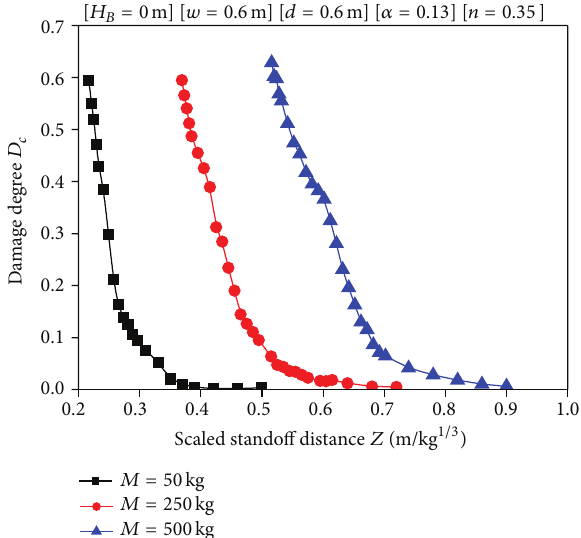
Figure 10: Effects of height of burst on the damage degree.